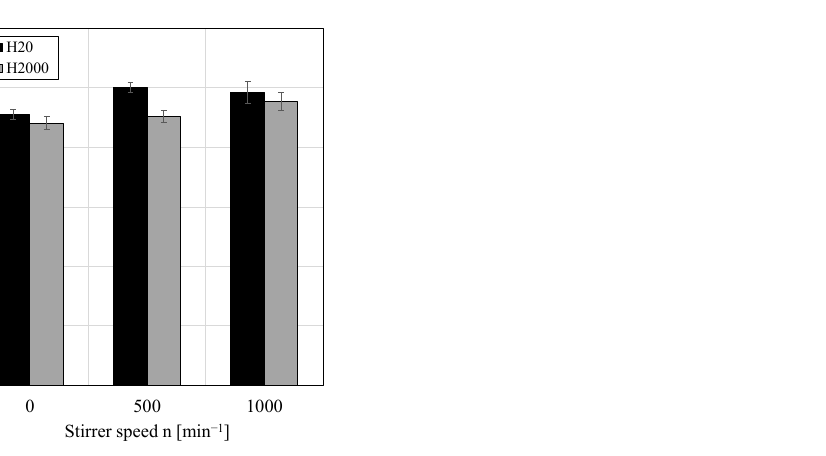
Figure 5. Permeability against stirrer speed within the stirred cell for w/o PEs stabilized by 0.5 wt.% of either particle type H20 or H2000. All pressure stepping experiments were conducted at least in duplicate and mean values are shown. Error bars represent the standard deviation. For comparison, the permeability of pure 1-dodecene was 3.58 ± 0.60 Lm − 2 h − 1 bar − 1 .